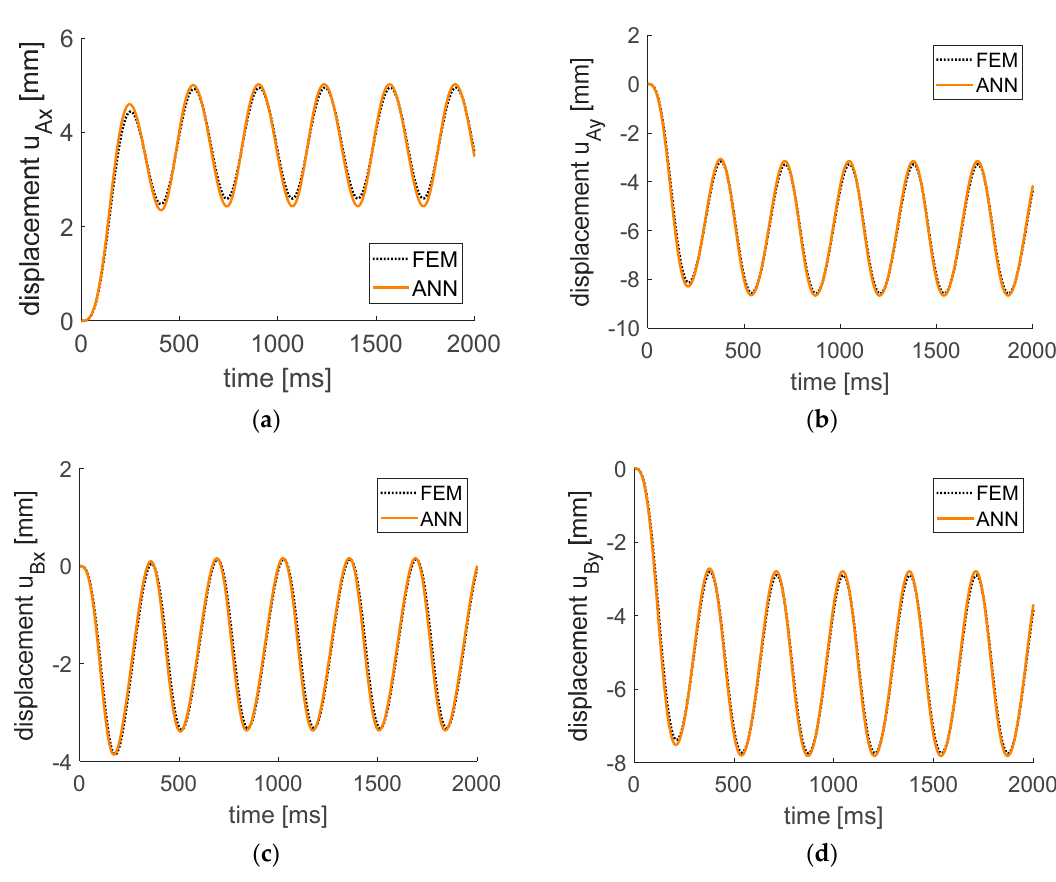
Figure 13. ANN obtained in example 2: ( a ) architecture, ( b ) performance of training.